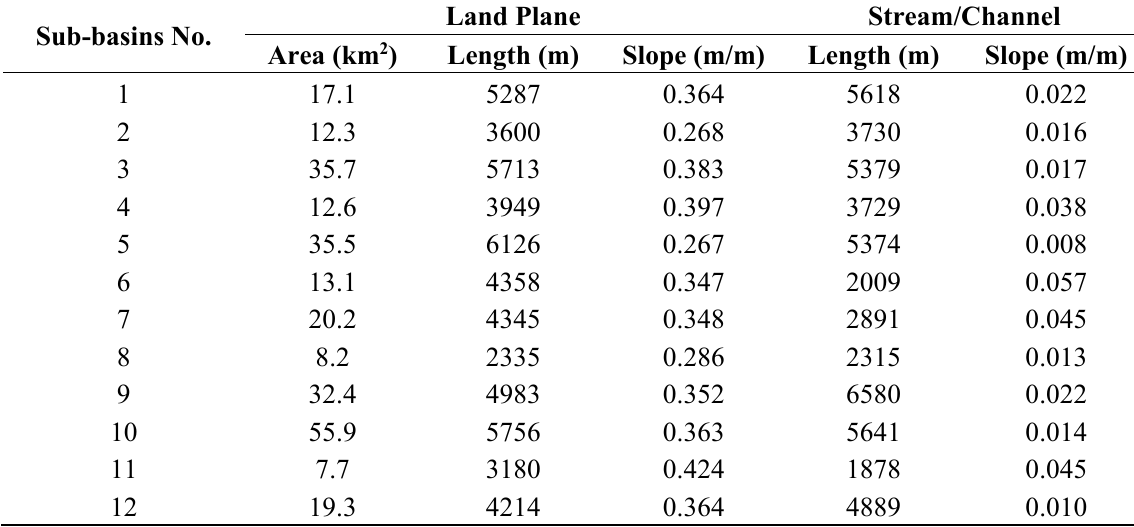
Figure 1. The location and area of Jianghe watershed. Table 1. The Topographical Parameters of the